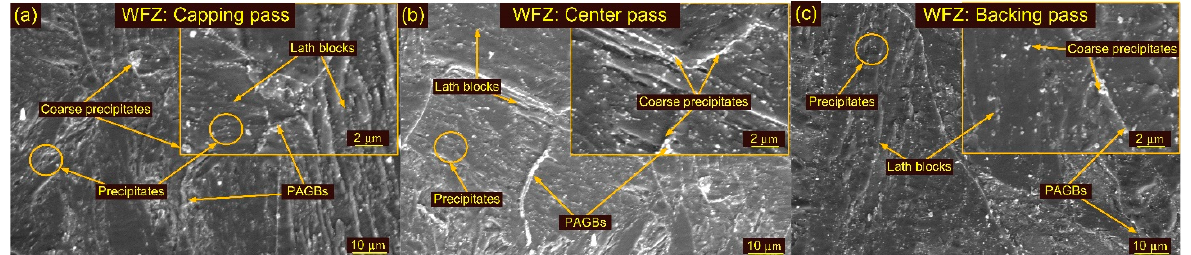
Figure 12. SEM images of weldments after T2 treatment: WFZ ( a ) capping pass, ( b ) center pass, ( c ) backing pass.